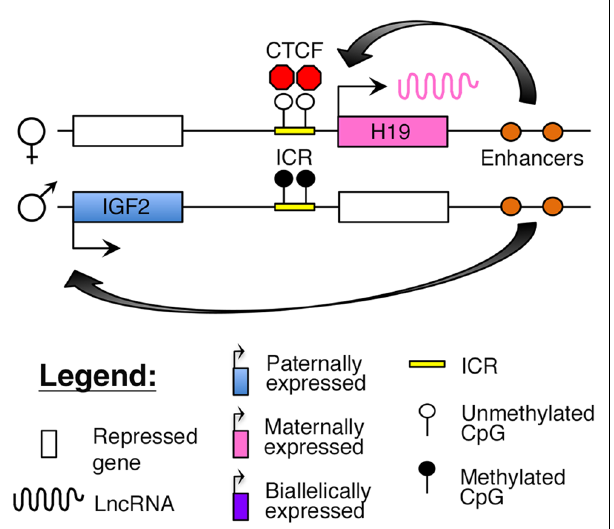
FIGURE 3 | Proposed model of imprinting at the H19–IGF2 locus: the H19–IGF2 locus consists of a paternally methylated ICR. On the maternal allele, this ICR is unmethylated and is bound by the insulator protein CTCF that prevents access of the IGF2 promoter to downstream